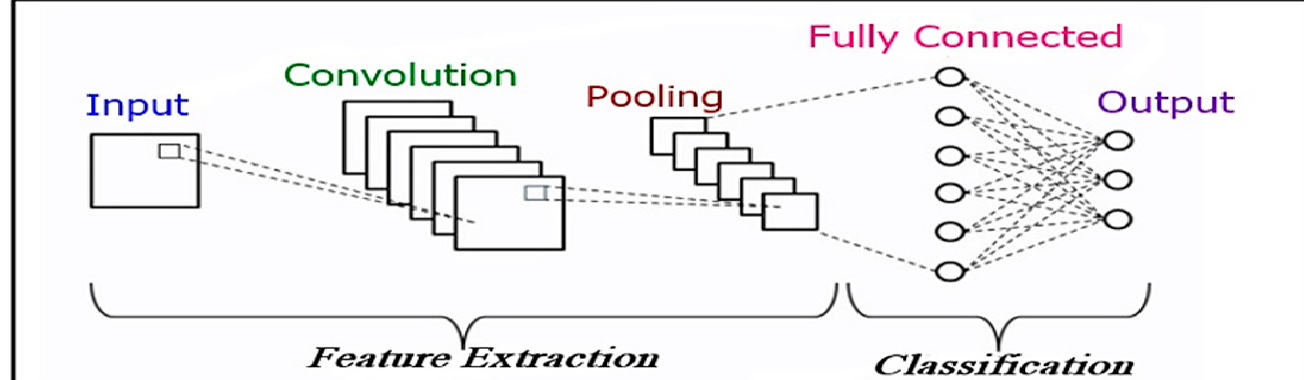
Figure 3. The block diagram of CNN architecture.